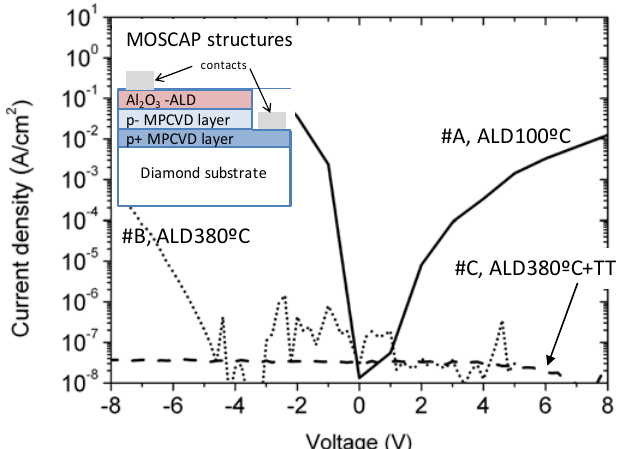
Figure 1. Representative I/V characteristics of the three samples under positive and negative bias. Sample A (ALD 100 ◦ C) showed strong leakage current under positive and negative biases, while for sample B (ALD 380 ◦ C), the leakage was strongly reduced, and sample C (ALD 380 ◦ C + annealing at 500 ◦ C for 30 min) showed no leakage current. MPCVD: microwave plasma-assisted chemical vapor deposition.